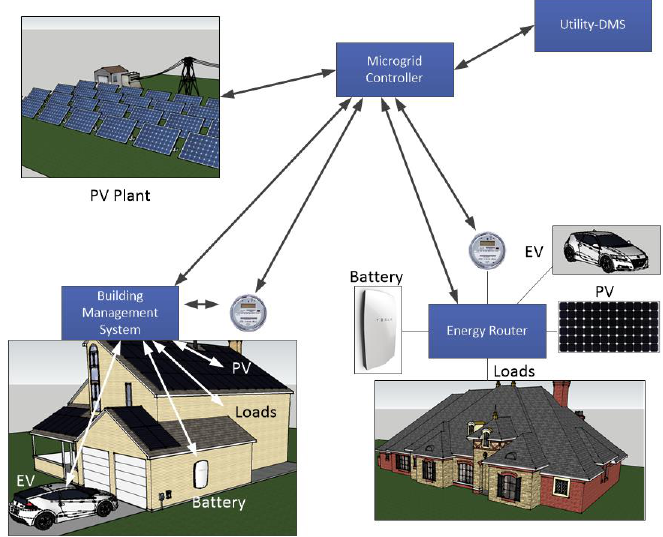
Figure 1. Example community